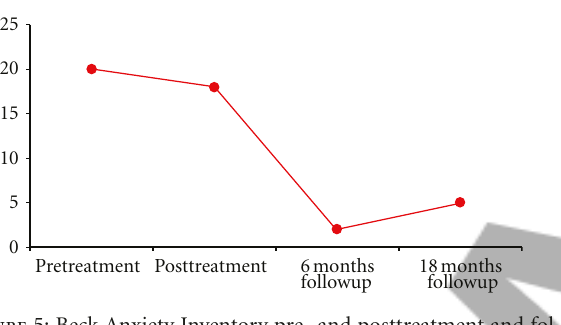
Figure 5: Beck Anxiety Inventory pre- and posttreatment and fol-